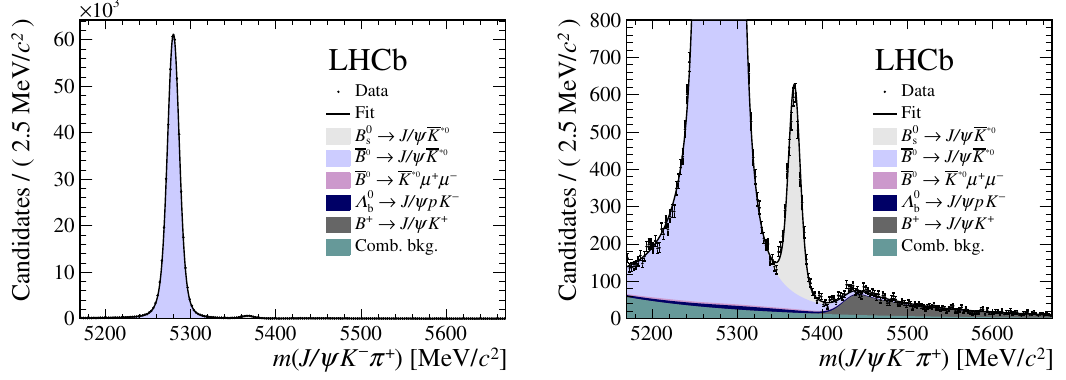
Figure 2 . Distribution of reconstructed J= K (cid:0) (cid:25) + invariant mass of the candidates in the J= mass region summing the three highest neural network response bins of each run condition, shown (left) over the full range and (right) over a restricted vertical range to emphasise the B 0 component. The solid line indicates a combination of the results of the (cid:12)ts to the individual bins. Components are detailed in the legend, where they are shown in the same order as they are stacked in the (cid:12)gure. The background from misidenti(cid:12)ed B 0 ! J= K (cid:3) 0 decays is included in the B 0 ! J= K (cid:3) 0 component.